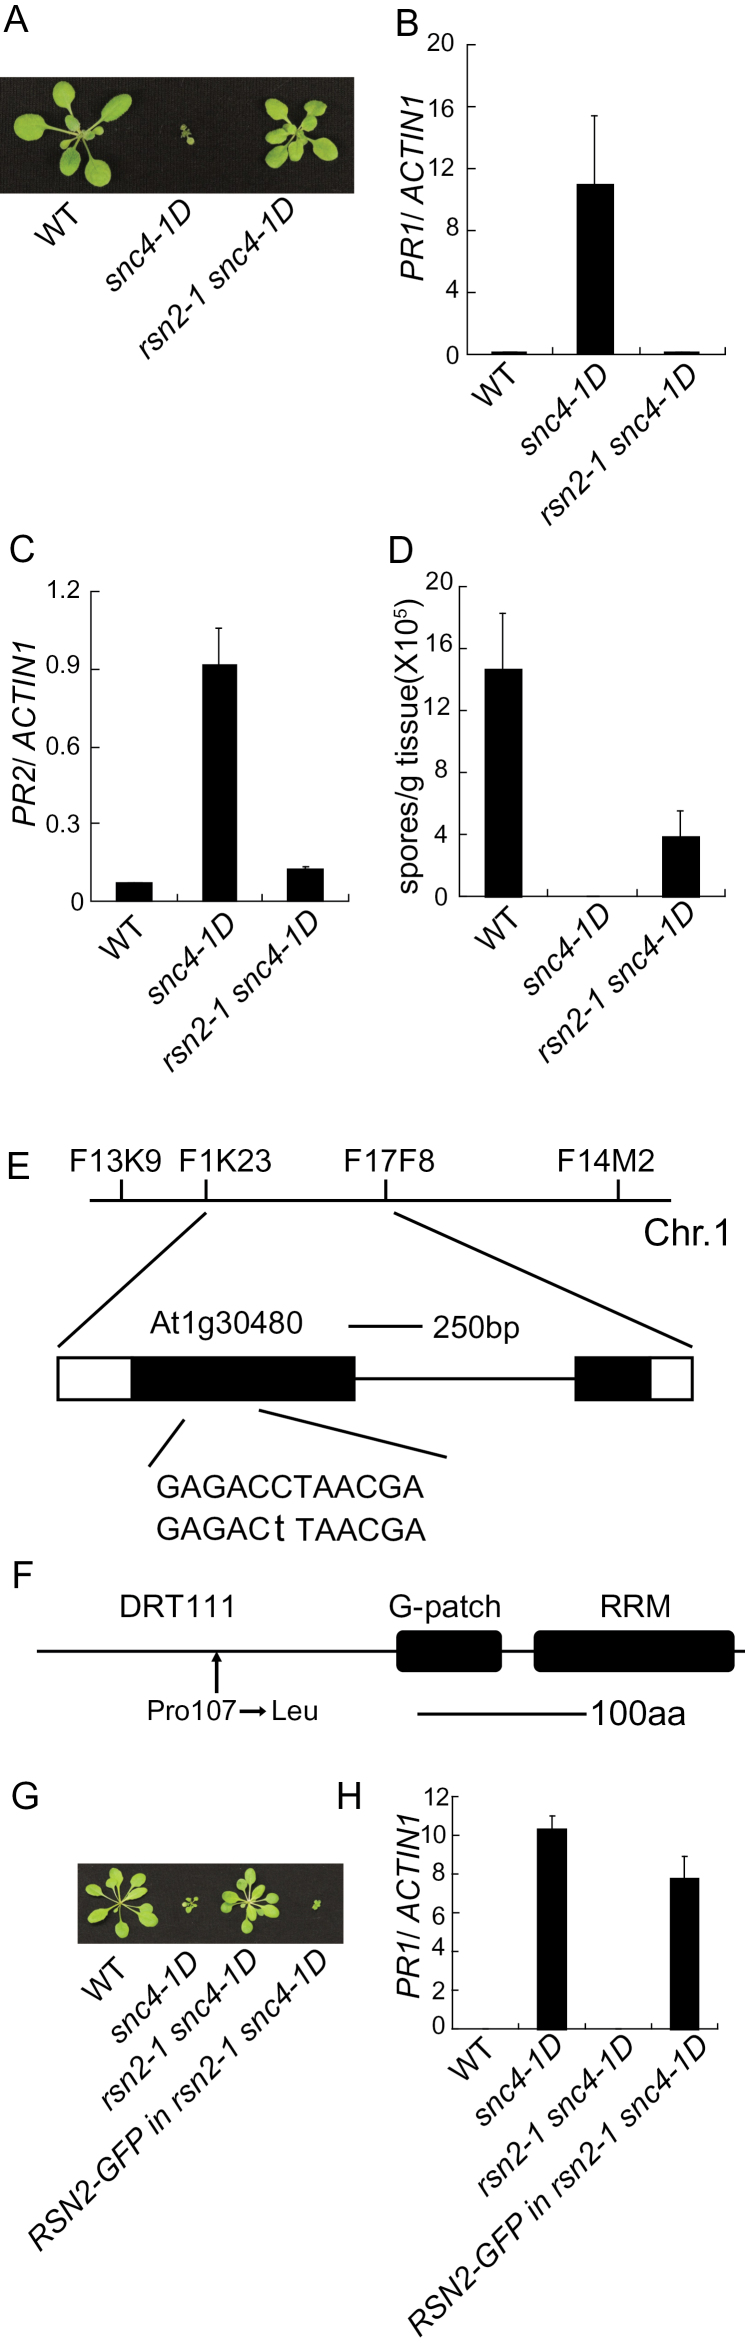
Identification and Characterization of rsn2-1 snc4-1D.
(A) Morphology of wild-type, snc4-1D, and rsn2-1 snc4-1D plants. Three-week-old soil-grown plants were photographed.
(B) Growth of H.a. Noco2 in wild-type, snc4-1D, and rsn2-1 snc4-1D plants. Two-week-old soil-grown plants were inoculated with H.a. Noco2 spores (5×104 spores ml–1).
(C, D) Expression of PR1 (C) and PR2 (D) in wild-type, snc4-1D, and rsn2-1 snc4-1D plants determined by real-time PCR. Total RNA was extracted from 2-week-old seedlings. cDNA was obtained by reverse transcription and subjected to real-time PCR analysis. Values were normalized to the expression of ACTIN1. Error bars represent standard deviations of three repeats.
(E) Map-based cloning of rsn2-1 and the gene structure of At1g30480. The positions of the mapping markers are indicated. Exons are indicated with black boxes. UTRs are indicated with empty boxes and the intron is indicated with a line.
(F) Protein structure of RSN2. Black boxes indicate conserved domain. RRM stands for RNA-recognition motif.
(G) Morphological phenotypes of WT, snc4-1D, rsn2-1 snc4-1D, and rsn2-1 snc4-1D with an RSN2–GFP transgene. The photograph was taken of 3-week-old soil-grown plants.
(H) Expression of PR1 in the indicated genotypes determined by real-time PCR. Values were normalized to expression of ACTIN1. Error bars represent standard deviations of three measurements.